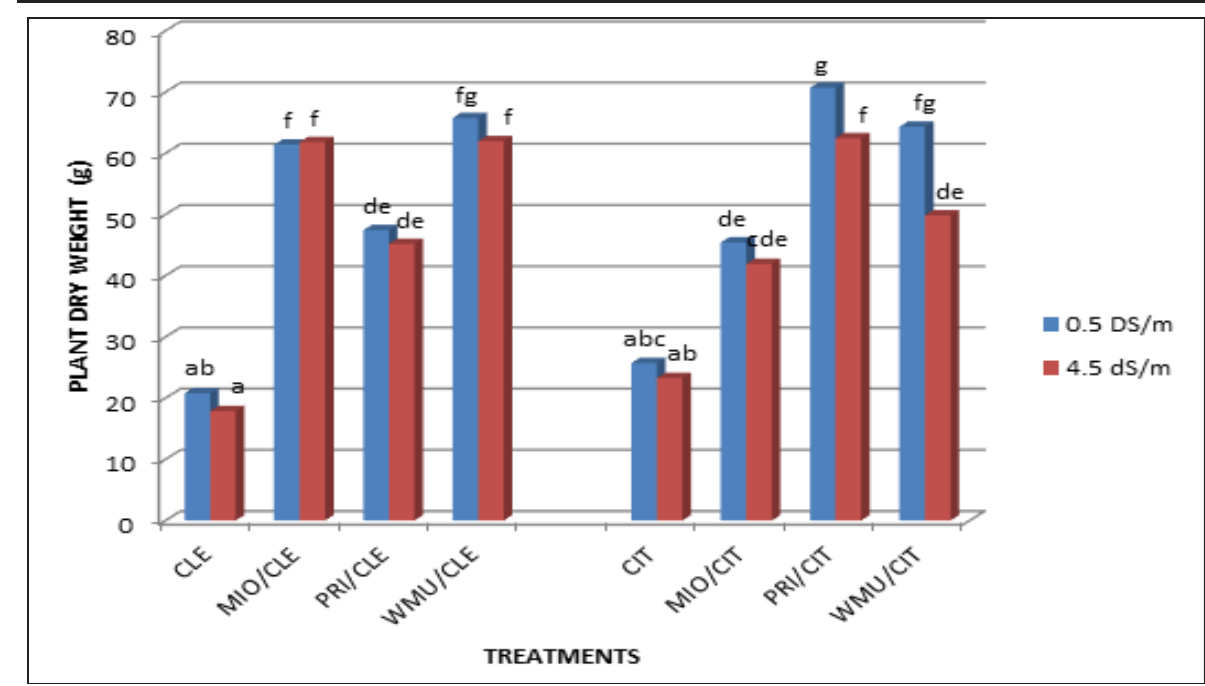
Figure 2. Effects of salt stress on plant dry weight (g) for each scion/rootstock combination at 90 days. *CLE (‘Cleopatra’), MIO (‘Mihowase’), PRI (‘Primosole’), WMU (‘W. Murcott’), CIT (‘Swingle citrumelo’).